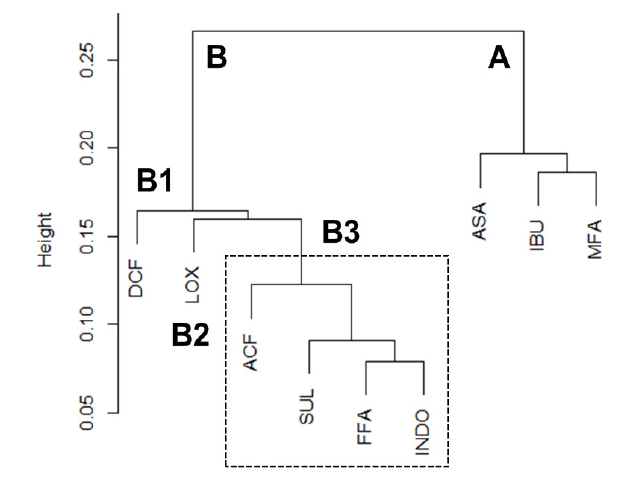
Figure 4. Cluster analysis of nuclear magnetic resonance (NMR). Combined chemical shift changes per each residue were vectorized and analyzed by hierarchical cluster analysis. NSAIDs were divided into two clusters (A and B), specific binders and non-specific binders, respectively. The cluster B is further divided in three (B1, B2, andB3) clusters (see text).